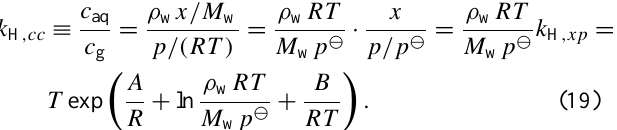
Figure 1. (a) The vertical finite-volume boxes and computational nodes (asterisk). (b) A schematic figure showing the diffusive fluxes ( J ) across boxes, which relate to concentration changes through mass